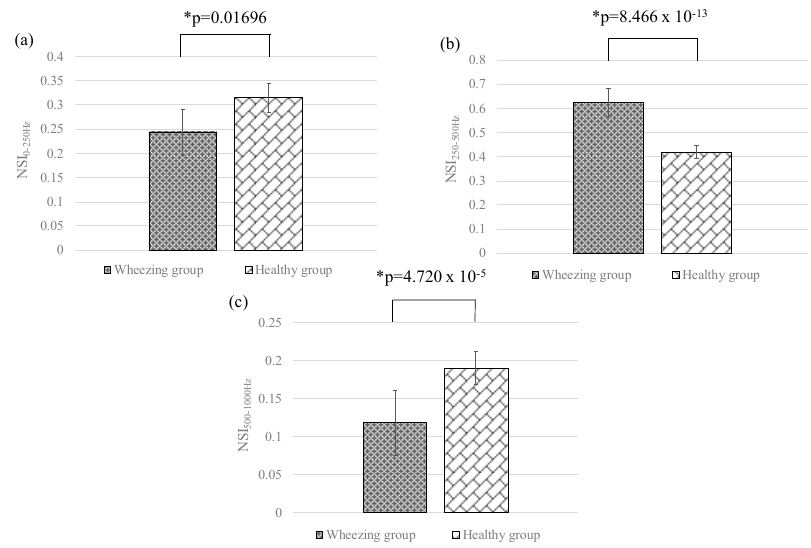
Figure 7. Means and standard deviations of ( a ) SI 0Hz-250Hz ; ( b ) SI 250Hz-500Hz ; and ( c ) SI 500Hz-1000Hz for different groups. Here, * denotes significant difference.